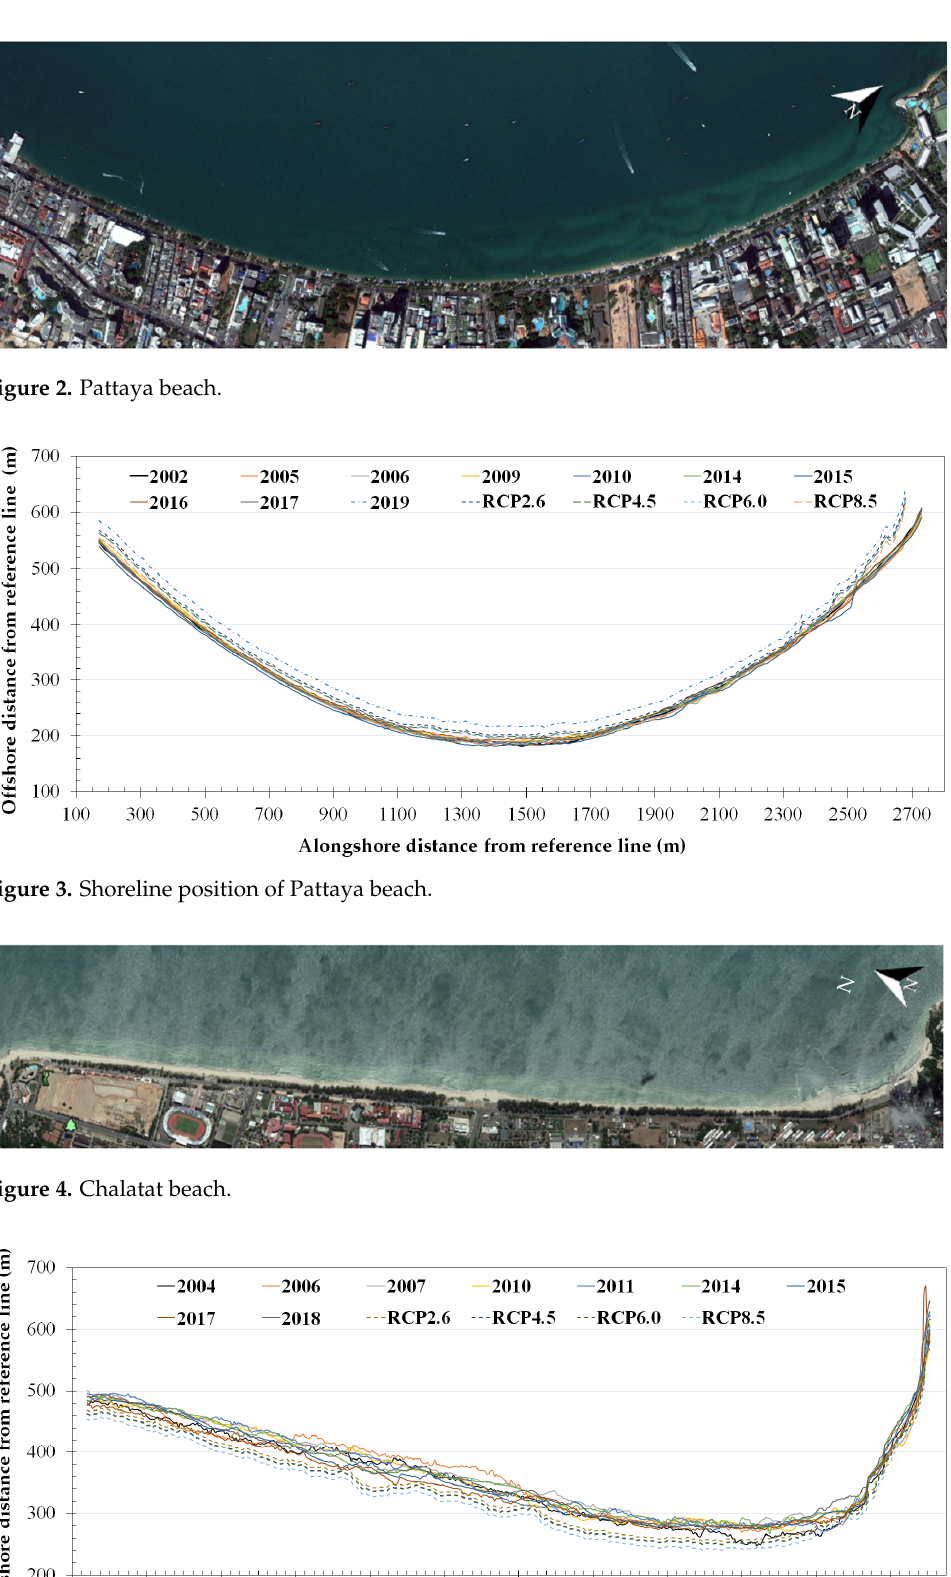
Figure 5. Shoreline position of Chalatat beach.